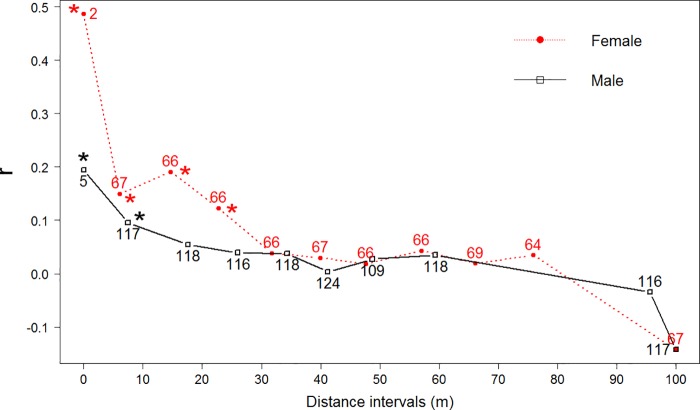
Pairwise relationship coefficients between female and male individuals (r) plotted against geographic separation (in meters, m) in Chanteraines rat population assessed using 13 microsatellite markers.The sample consisted of 49 males and 37 females; sample size at each distance is specified. Coefficient values significantly different from zero are shown with an asterisk.